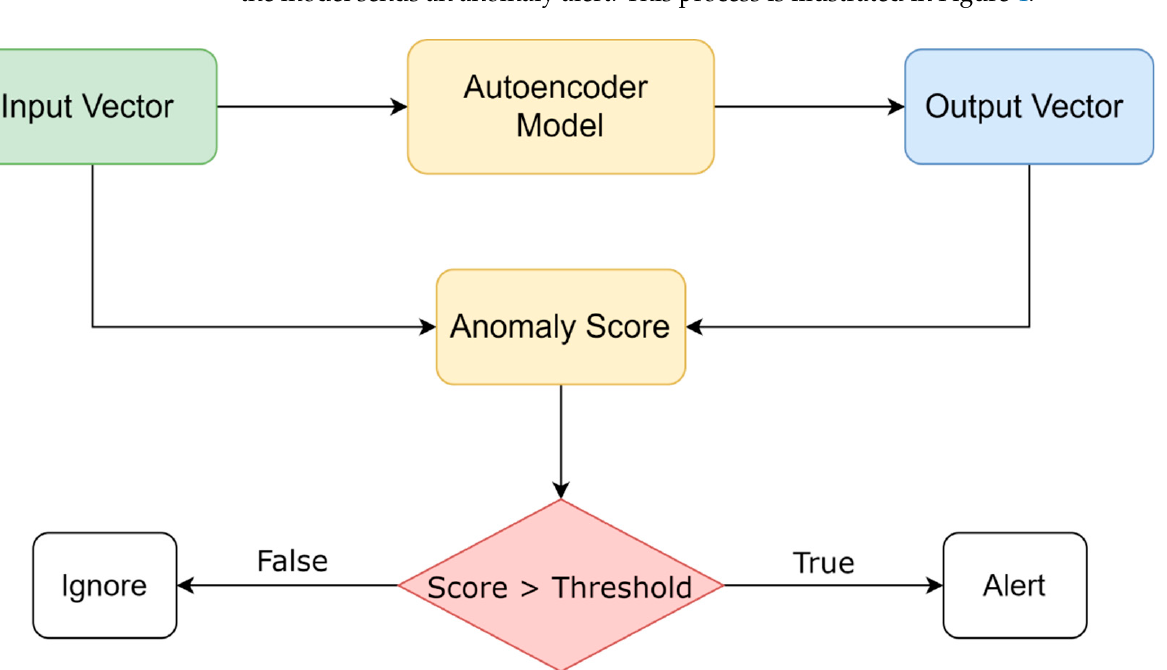
Figure 4. An Illustration of the process of calculating the anomaly score.